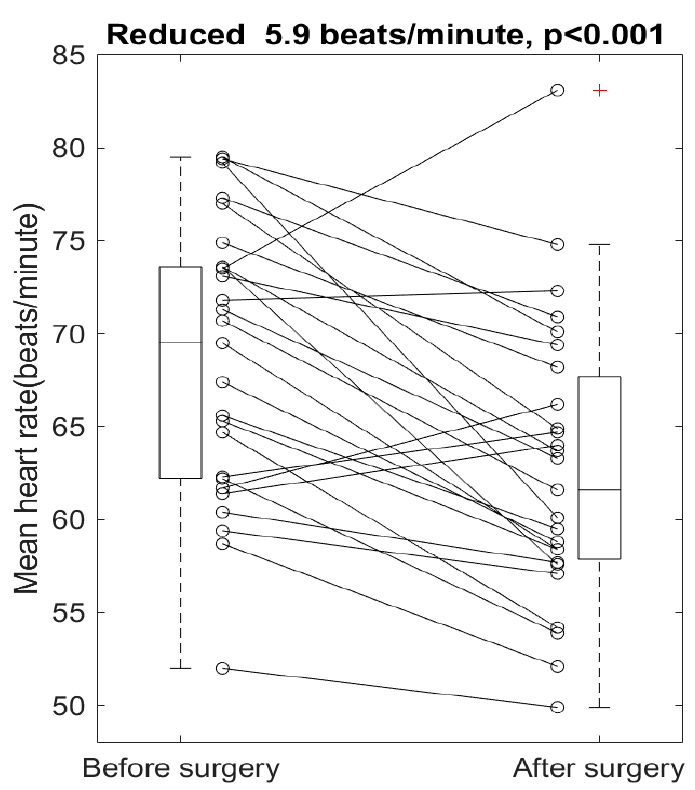
Figure 3. Individual mean heart rate changes revealed a significant reduction after the surgery. The surgery reduced the mean heart rate from 68.6 ± 7.3 to 62.7 ± 7.5 beats / minute ( p < 0.001). Each boxplot displays a five-number summary: the minimum, the maximum, the median, and the first and third quartiles. There was an outlier in the postoperative mean heart rates.